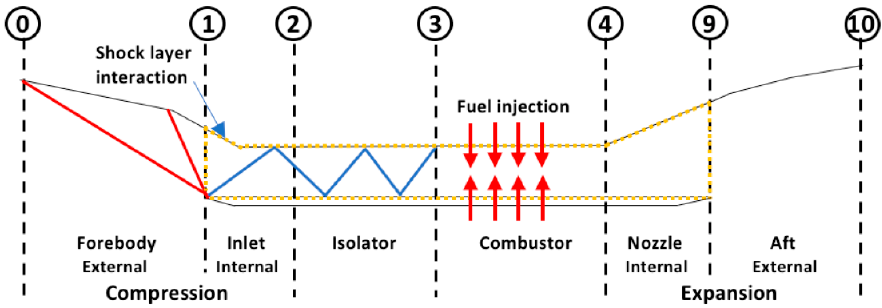
Figure 1. Flow stations in a scramjet engine.